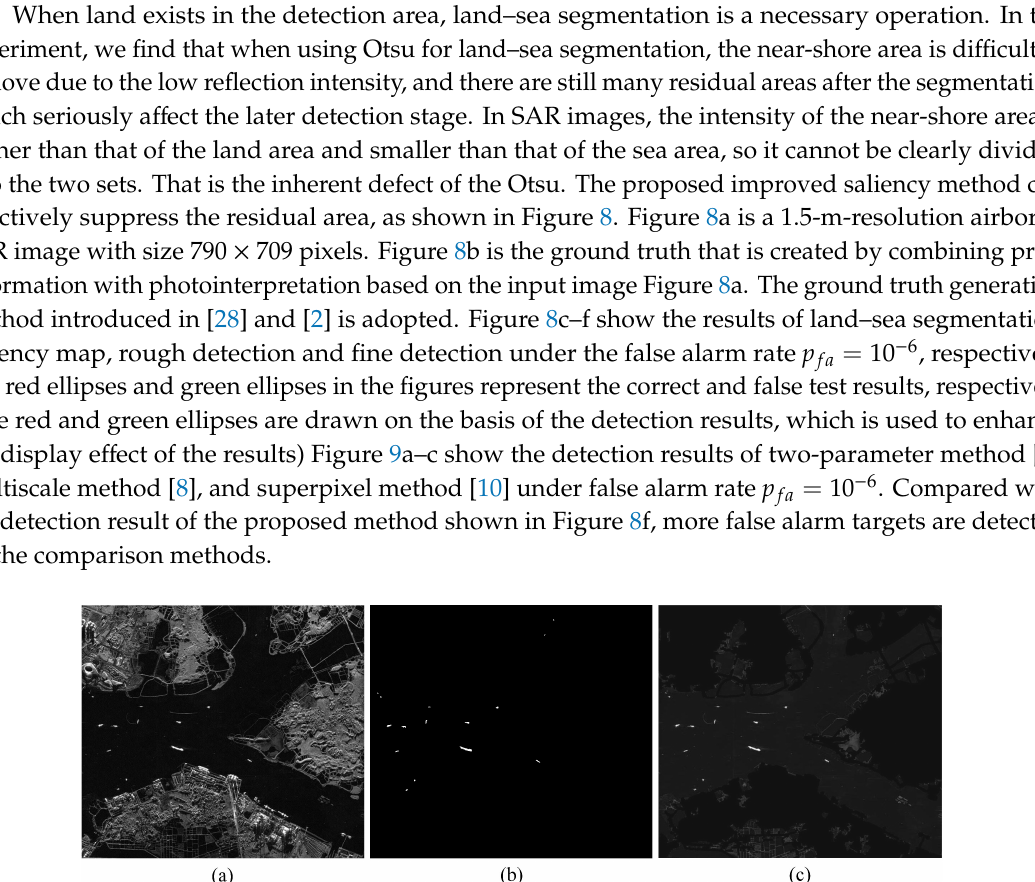
Figure 7. Comparison of clutter fitting result.